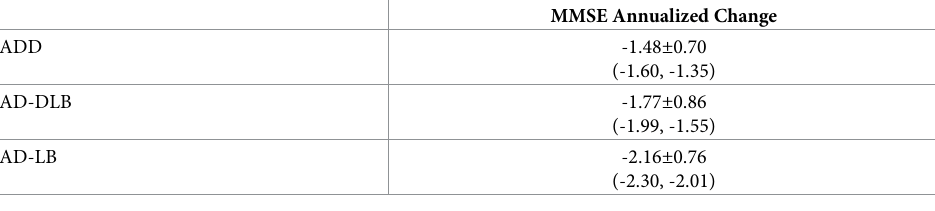
Table 2. Annualized MMSE change for ADD, AD-DLB, and AD-LB